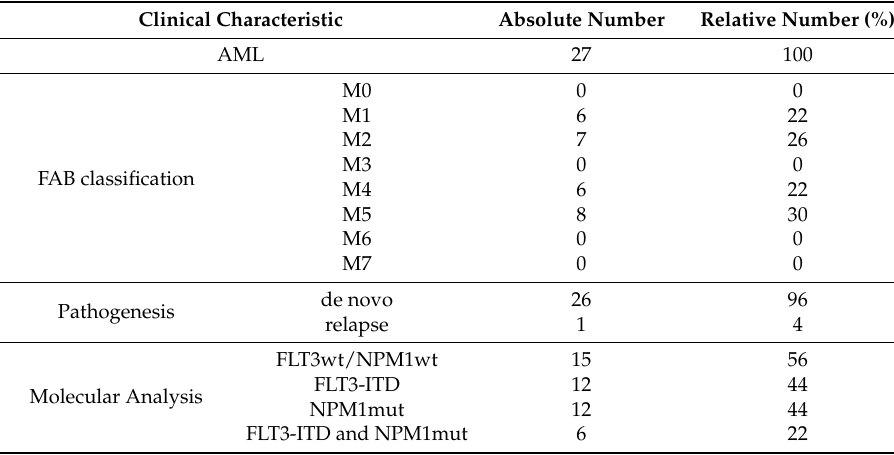
Table 2. AML cohort study samples